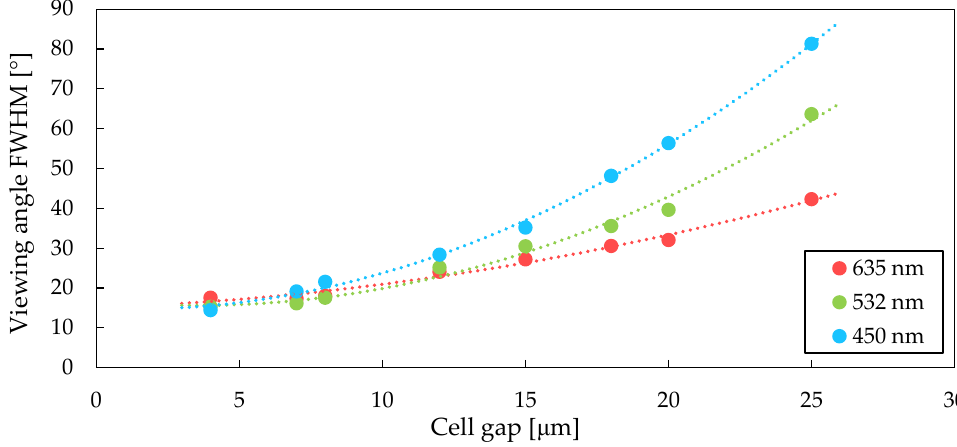
Figure 10. LC layer thickness impact on viewing angle (FWHM).